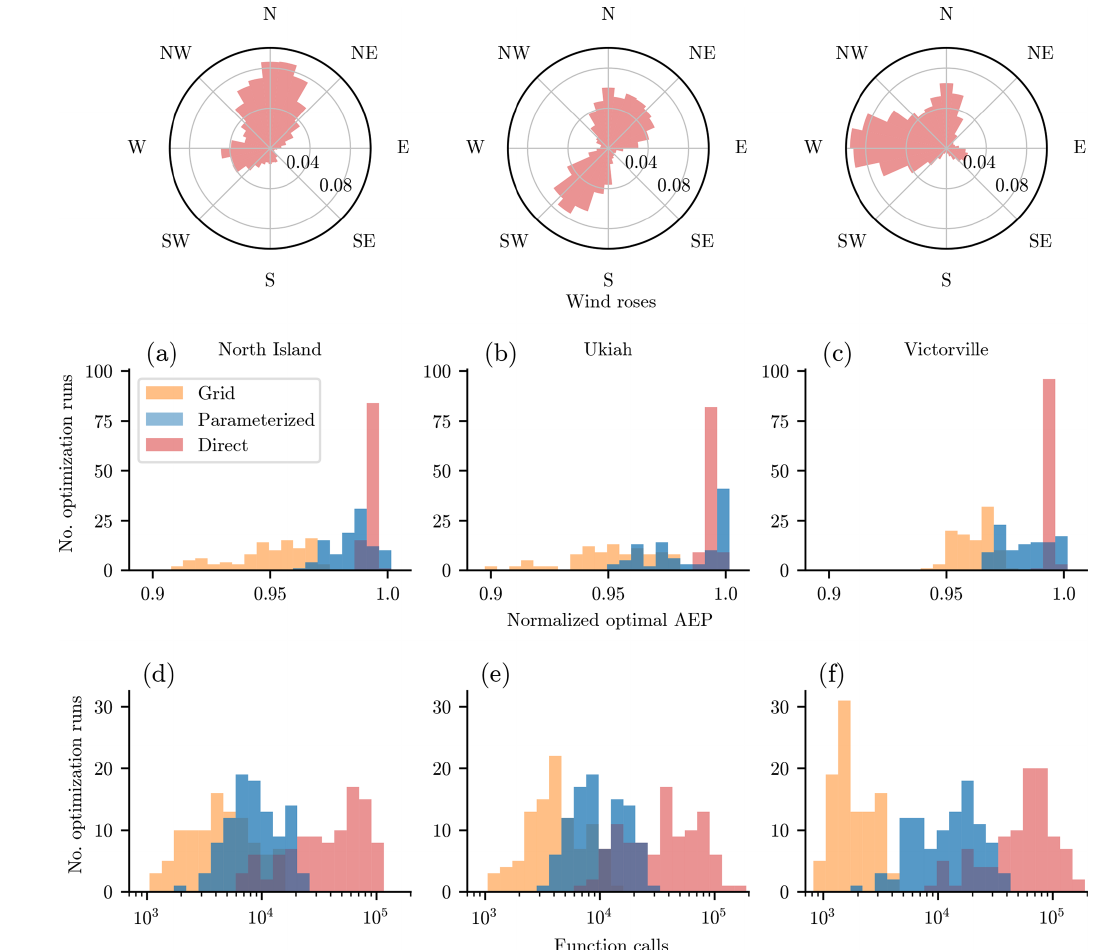
Figure 11. Results from 100 randomly initialize optimizations for wind farms with varied wind roses and 100 wind turbines. The farm optimized had the Princess Amalia boundary, and the average turbine spacing was 4 rotor diameters. Shown are results using the grid tur- bine parameterization, our new boundary-grid parameterization, and direct optimization. The optimal annual energy production distribution achieved for each of the optimization runs, in wind farms with varied wind roses. Wind rose from (a) North Island, California, (b) Ukiah, California, and (c) Victorville, California. The number of function calls required to converge for each of the optimization runs, in wind farms with varied wind roses. Wind rose from (d) North Island, California, (e) Ukiah, California, and (f) Victorville,